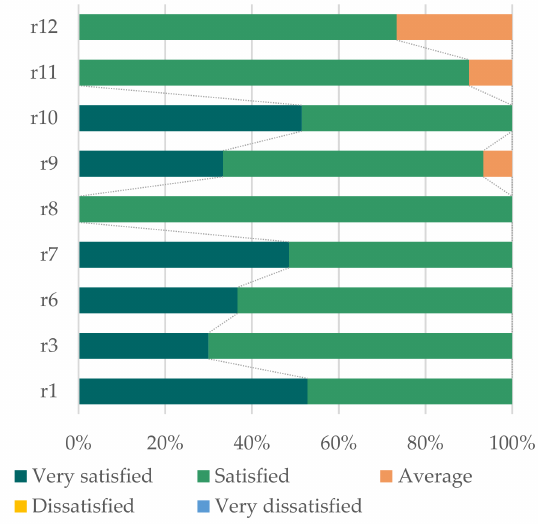
Figure A16. User satisfaction in Zhujiang